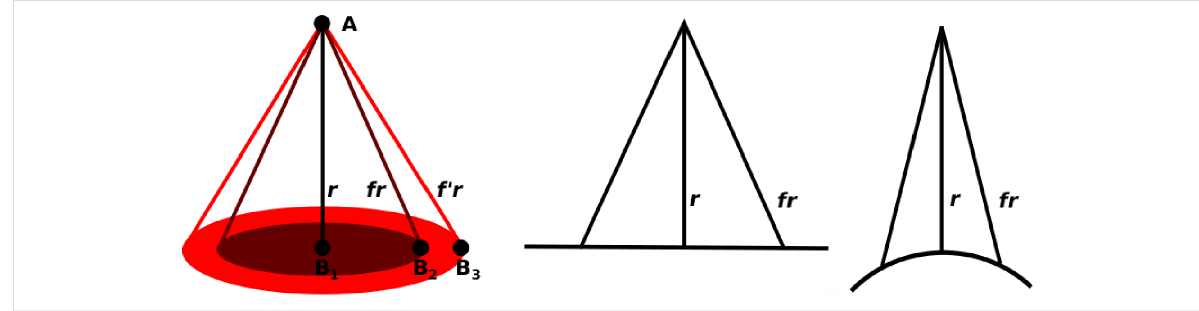
Figure 4: Left: The disk covering the atoms of molecule B seen by an atom in molecule A expands with increasing lateral height fr of the “vision cone”. Right: The aperture of the vision cone becomes smaller when molecule B is not planar but bent.